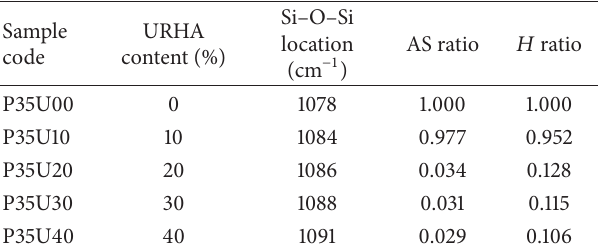
Table5:Ratiosofpeakarea(AS)andpeakheight( 𝐻 )fromtheFTIR spectra of brick specimens at Si–O–Si stretching